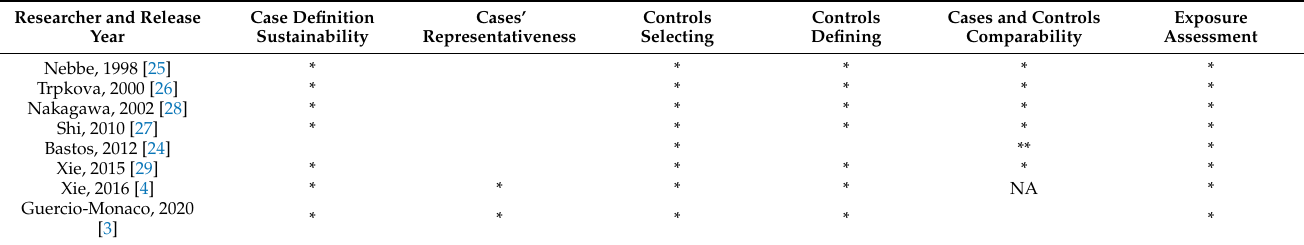
Table 3. Newcastle Ottawa Scale rating of the identified